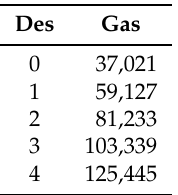
Table 9. Gas Used in allChildrenRevocation() ABI.